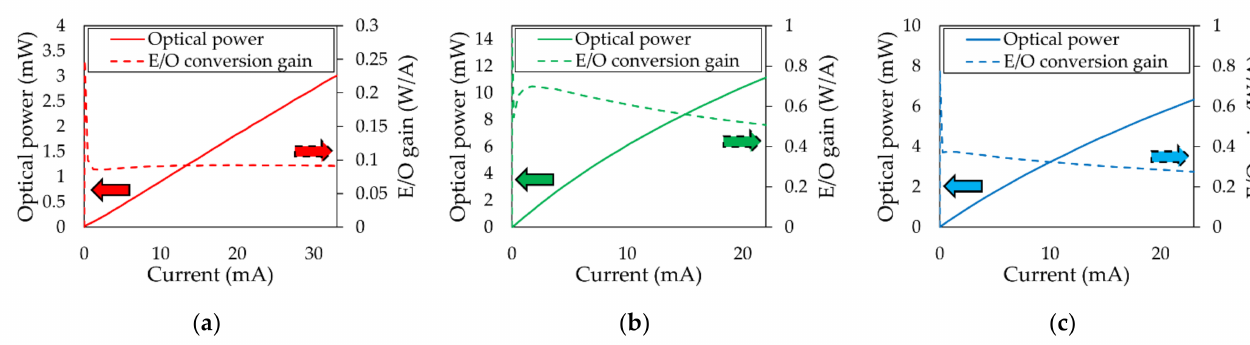
Figure 4. Optical power and E/O efficiency of the ( a ) red, ( b ) green, and ( c ) blue LEDs with respect to the input